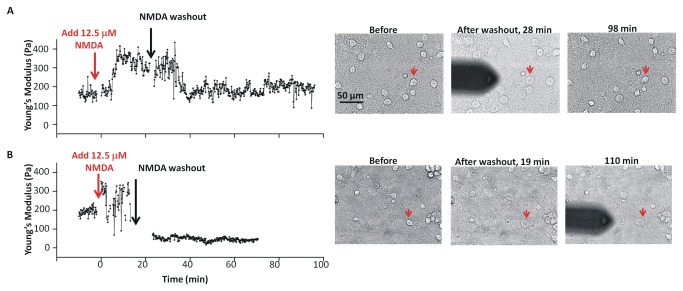
Elasticity changes as a function of time.Young’s modulus and bright field images of two neuronal somata measured as a function of time before, during exposure to 12.5 µM NMDA, and after washout. The red arrows on the optical images indicate the neurons that were measured in the indentation experiment.